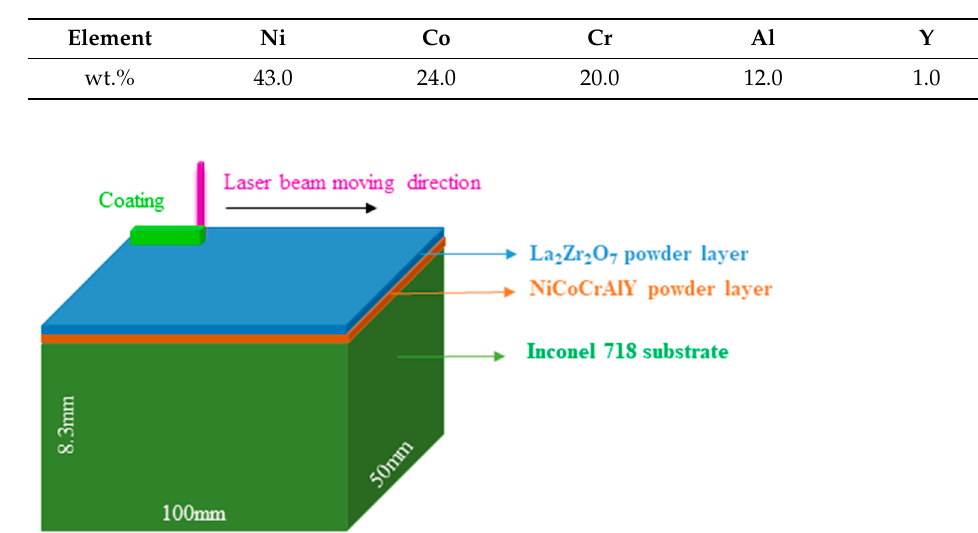
Figure 1. Schematic diagram of pre-set powder layer before laser cladding.